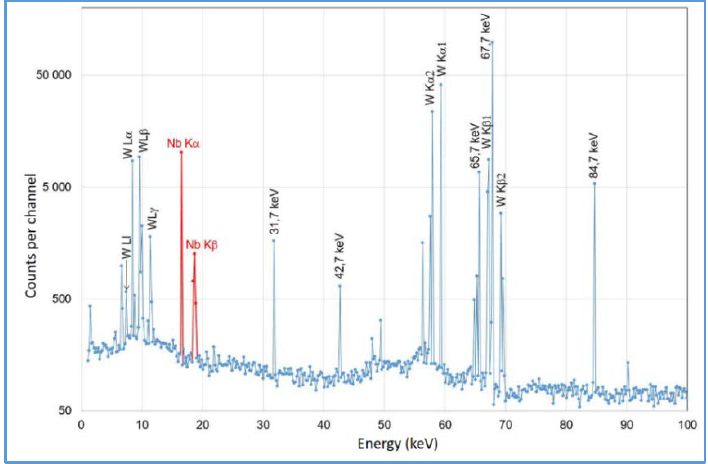
Fig. 4. Simulated spectrum following the decay of 182 Ta in a niobium dosimeter